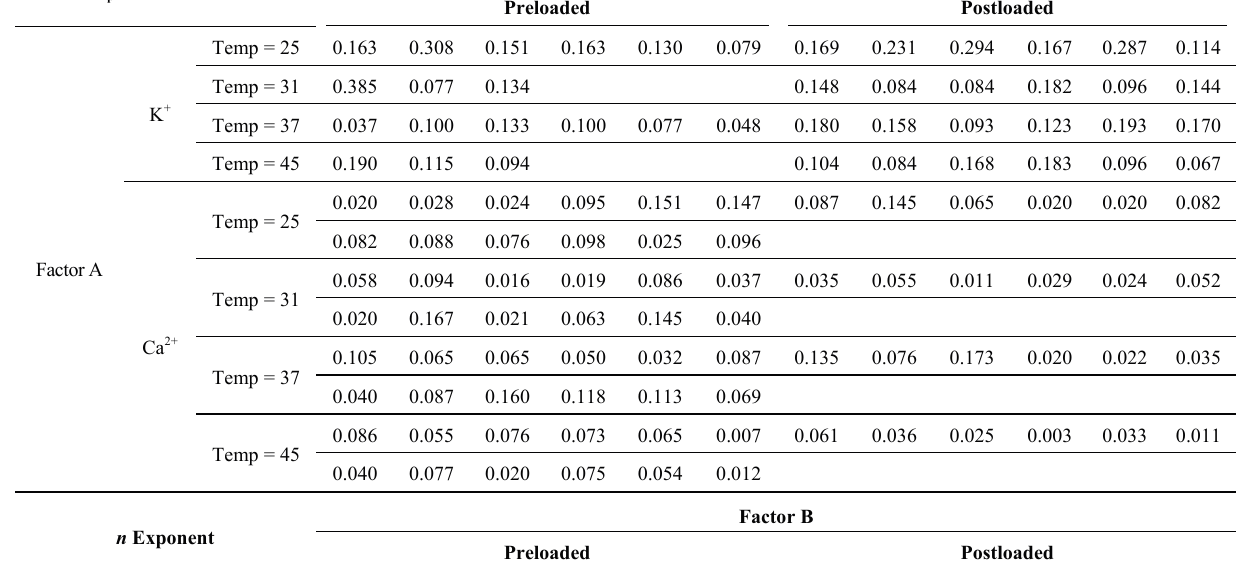
Table A1. Nested ANOVA setup for statistical analysis of ion (Factor A) and loading (Factor B) as main effects with Temperature as the nested variable for rate constant, k ( top ) and diffusional exponent, n , ( bottom